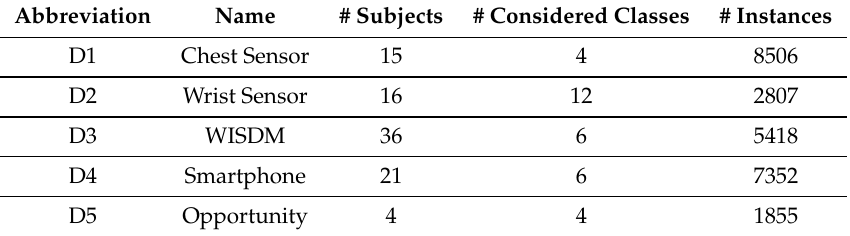
Table 1. Datasets